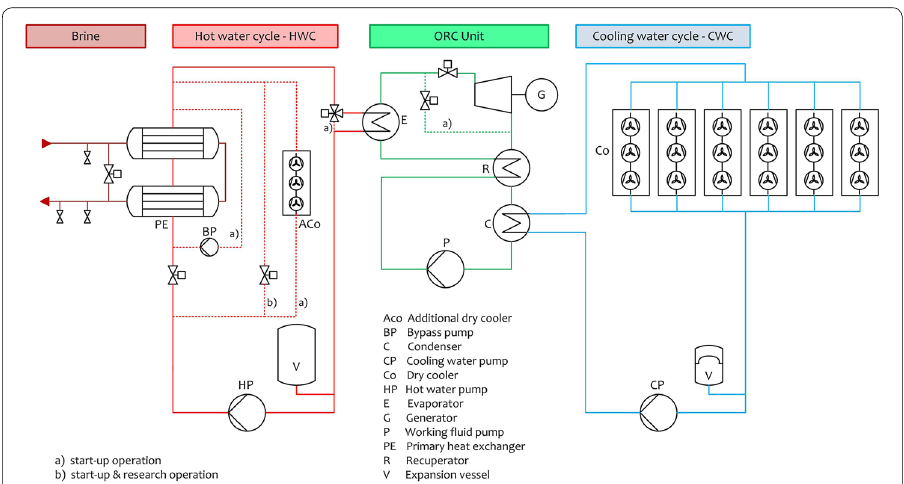
Fig. 1 Flow diagram of the demonstration power